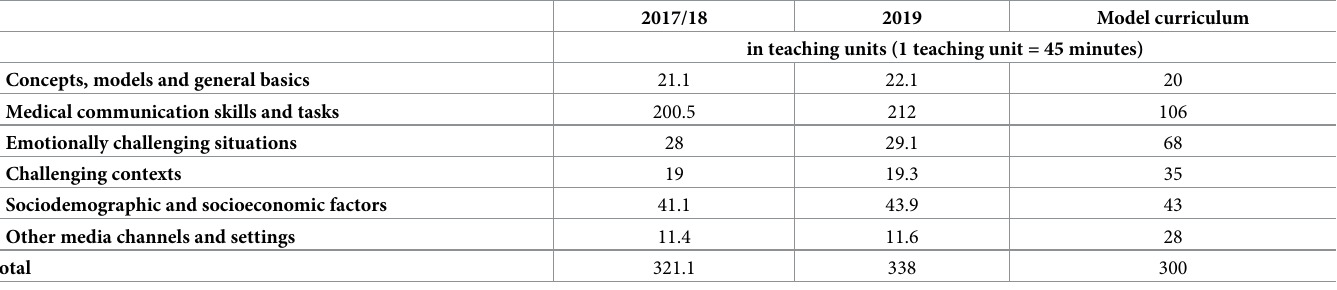
The estimates are based on the number of teaching units of a course and the estimated percentage of time spent on communication-related content. The interviewees gave this information on a 5-point scale, with the five categories 0–20%, 20–40%, 40–60%, 60–80% and 80–100%. The category mean (e.g., 20–40% = 30%) is multiplied by the number of teaching units of each course to estimate the teaching units spent solely on communication.